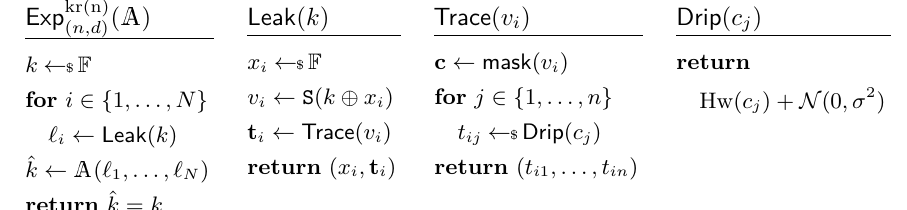
Figure 2: The key recovery game given noisy Hamming weight leakage of a masked S -box